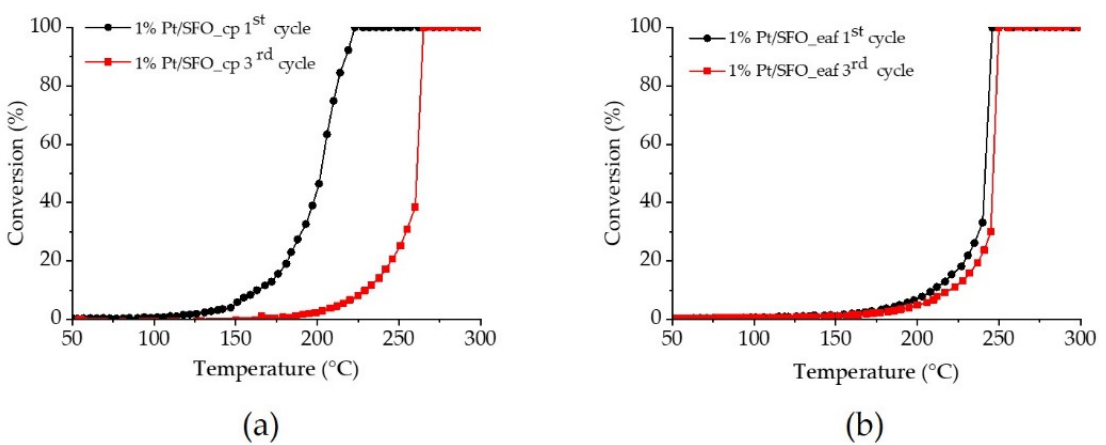
Figure 7. CO oxidation on Pt/SFO synthesized by complexation ( a ) and fusion synthesis ( b ). For clarity, the first and third runs are shown. Reaction conditions: 6000 ppm CO, 10,000 ppm O 2 , 200 mg catalyst, total flow: 10 L/h. The possible growth of platinum nanoparticles can be studied using HAADF-STEM analysis before and after catalytic testing (Figure 8).